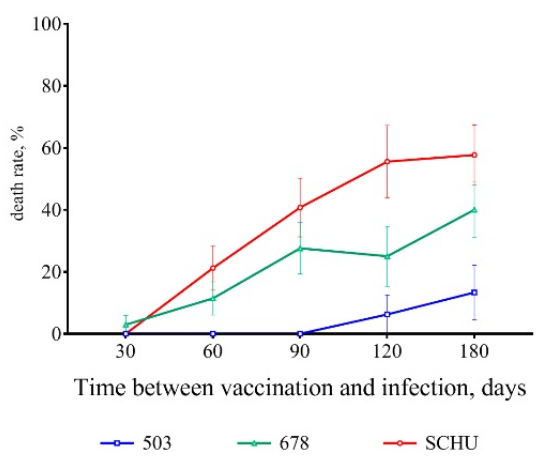
Figure 6. Dynamics of the mortality rate with an increase in the period between the vaccination of mice and their infection with virulent strains of F. tularensis : subsp. holarctica 503, subsp. mediasiatica 678, and subsp. tularensis SCHU. Values are indicated with the standard error of the mean (SEM) for each measurement point. Table 3. Mortality rate and lifespan of mice immunized 90 days before the experiment and infected with 6 virulent strains of F. tularensis . Values are indicated with the standard error of the mean (SEM). Strain Subspecies Mortality Rate, %